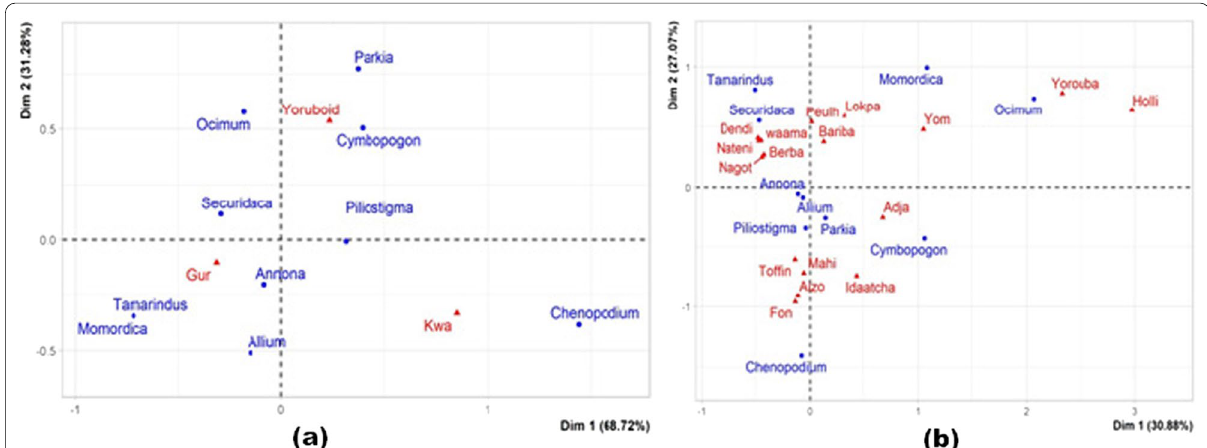
Fig. 6 Projection of the most cited anti-snakebite species and a sociolinguistic groups and b ethnicities on the two principal component axes